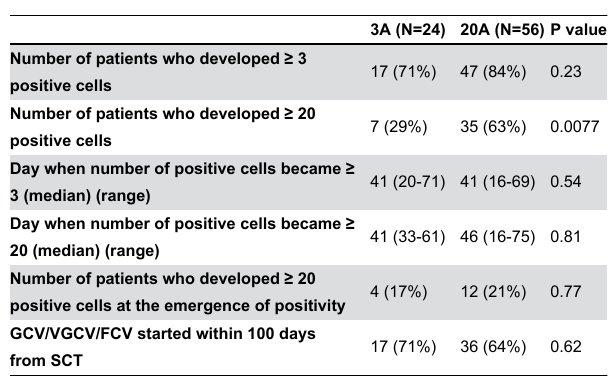
Table 2. Positive conversion of CMV antigenemia and preemptive therapy for CMV